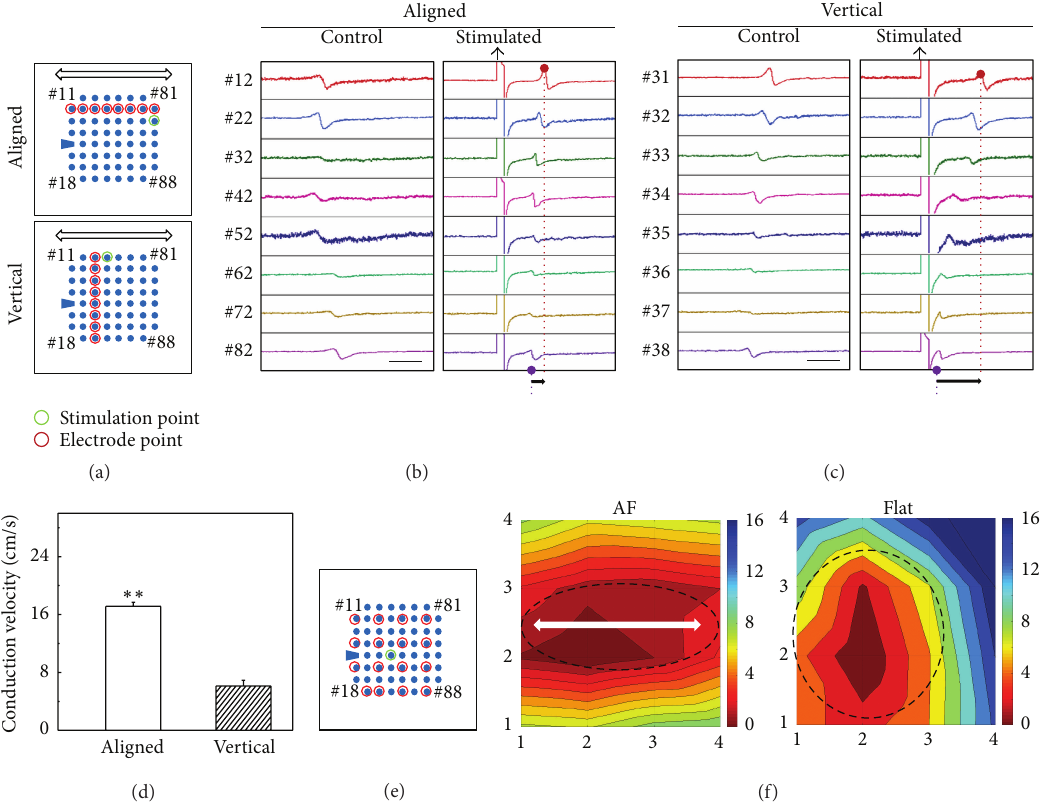
Figure 6: Propagation of the field potential of IMR hiPS-cardiomyocytes. (a) Electrode arrangement for recording and stimulation. The AF orientation is marked by arrow. (b, c) Time course of the field potential along (b) and perpendicular (c) to the fiber direction. The scale bar = 0.2 s. The black arrows mark the starting point of stimulation. (d) Conduction velocity of the stimulated contraction in different directions (means ± s.e., 𝑛 = 3 , ∗∗ 𝑃 < 0.01 ). (e) Electrode arrangement for activation map analysis. (f) Activation maps showing the propagation of stimulated contraction at day 14. The color bar from red to blue is linearly divided from 0ms to 16ms. The arrow marks the AF orientation. The encircled line marks the shape of the isochrones of the